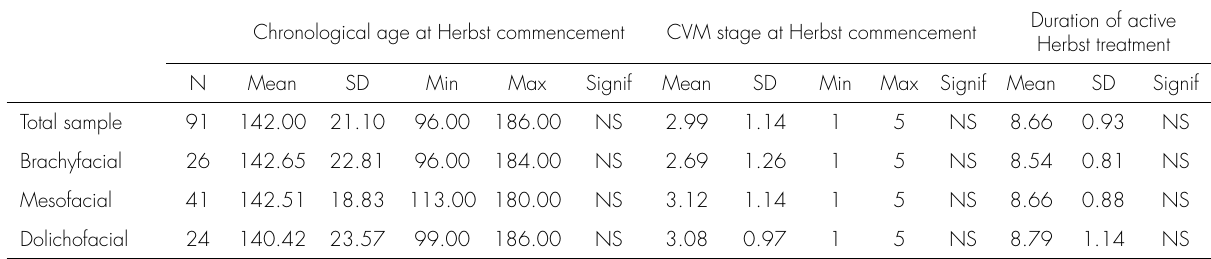
Table III. Age at commencement and duration of Herbst treatment (months).